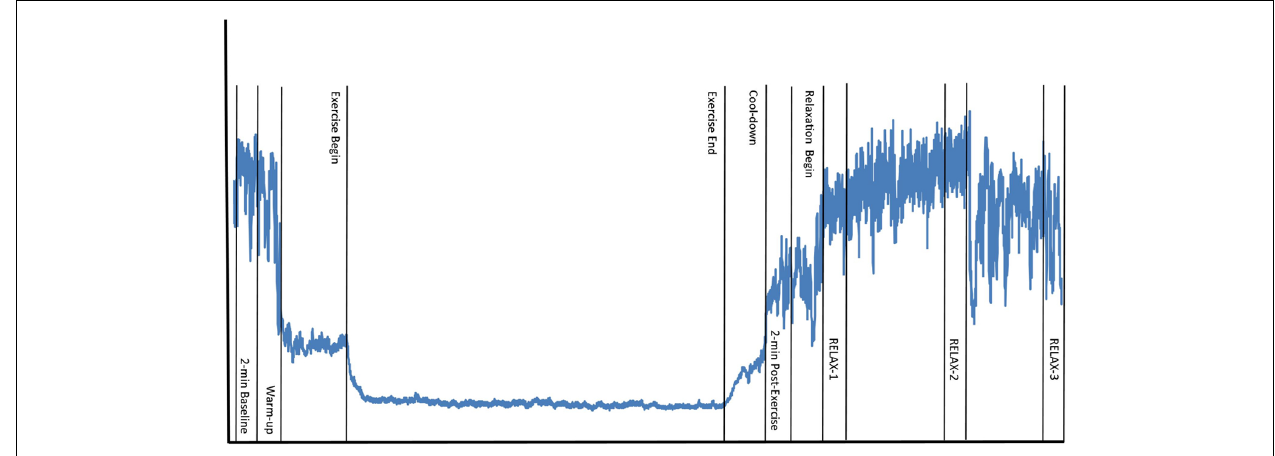
FIGURE 1 |Testing schedule and data collection time points. Wavy line represents example R–R interval time series over the course of one experimental session, including the following time points: 2-min baseline, 5-min warm-up, 20-min exercise,